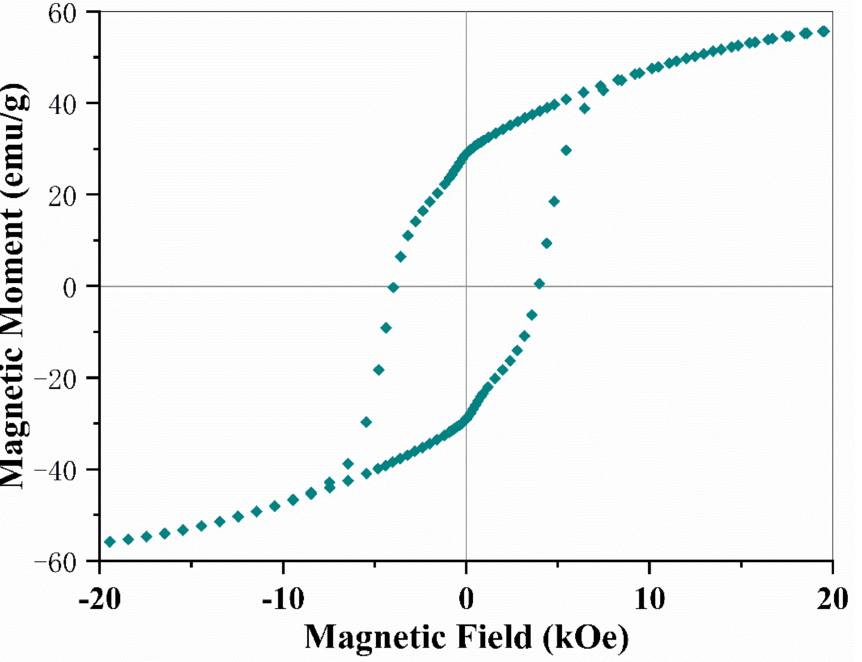
Figure 6. The magnetic M-H hysteresis loop of La 0.5 Sr 0.5 Fe 12 O 19 ceramics, being sintered at 1350 ◦ C for 3 h and subsequently annealed in an O 2 atmosphere at 800 ◦ C for three times, each one was maintained 3